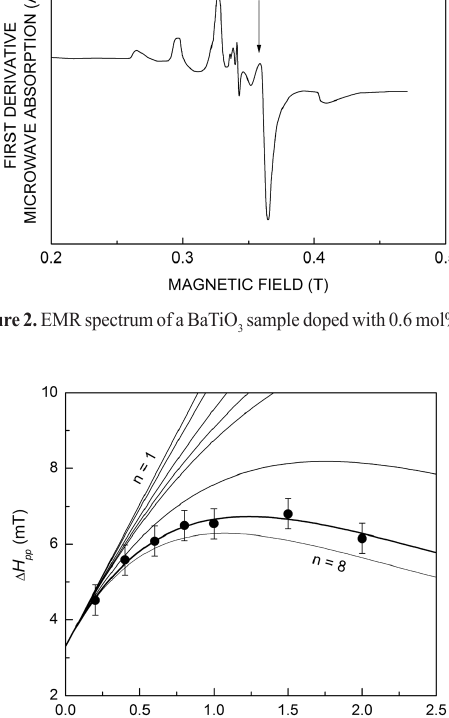
Figure 3. Concentration dependence of the peak-to-peak linewidth, Δ H , in Gd-doped BaTiO . The circles are experimental points; the pp 3 curves represent results of calculations for eight different ranges of the exchange